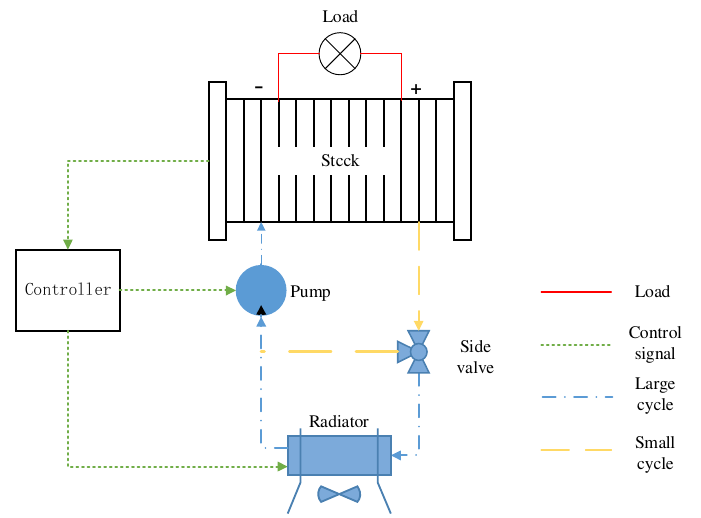
Figure 1. Diagram of cooling system structure.